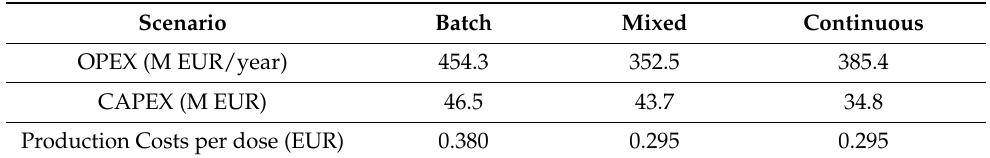
Table 1. Total annual operating costs (OPEX) and capital investment costs (CAPEX) necessary for the production of 400 million doses per